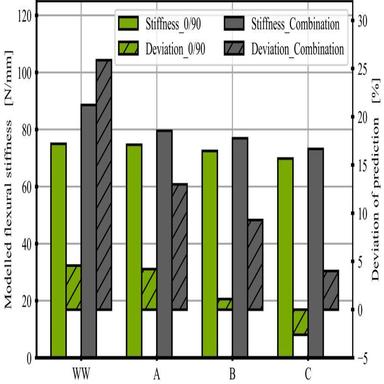
Analytically predicted flexural stiffness considering out-of-plane towpreg waviness and deviation to the experimental results of the 2D plate with 0/90 and combined towpreg design ("WW": without considering towpreg waviness as a reference, "A": waviness of the skin and inner 0-towpregs from the 0-towpreg-1; "B": waviness of the skin and inner 0-towpregs from the 0-towpreg-1 and − 2, respectively; "C": waviness of the skin and inner 0-towpregs from the 0-towpreg-2).